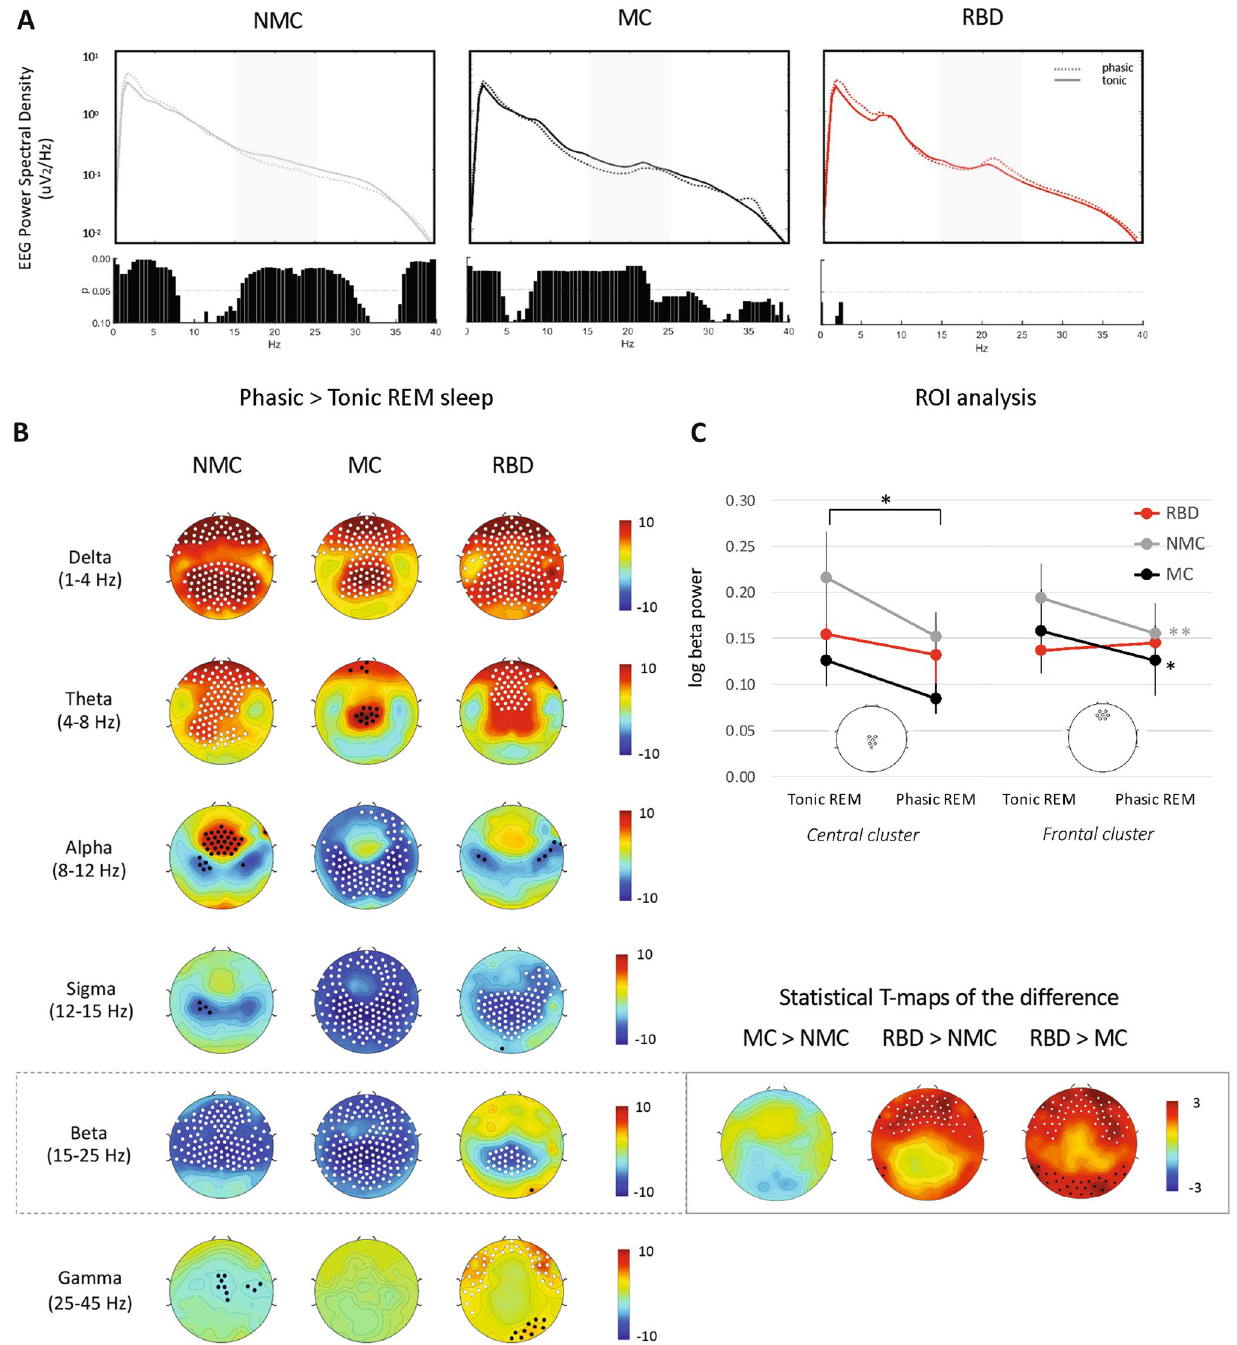
Figure 1. Spectral differences between phasic and tonic REM in RBD patients and controls. ( A ) Global EEG power spectra in phasic (dotted light) and tonic (continuous line) REM in the three groups. FDR-corrected p values from paired t-tests for the comparison between states within groups are shown below each plot, respectively. Greyed areas represent the beta band. ( B ) Normalized change in log power between phasic and tonic REM sleep across indicated frequency bands (delta: 1–4 Hz; theta: 4–8 Hz; alpha: 8–12 Hz; sigma: 12–15 Hz; beta: 15–25 Hz; and gamma: 25–40 Hz) for non-medicated controls (left column), medicated controls (middle column) and RBD patients (right column). White dots indicate p < 0.05 and black dots p < 0.1 after SNPM correction for one-sample t-test between both REM sleep sub-stages. Statistics on the changes showed significant differences between groups in the beta range only and are shown in the right insert. Individual channel t-maps are represented, with white dots indicating channels with SNPM corrected p < 0.05 and black dots uncorrected p < 0.05 after unpaired t-tests on the phasic to tonic REM power difference. ( C ) ROI analysis for central and frontal changes in absolute beta power between tonic and phasic REM sleep. Central and frontal ROIs were centered around Fz and Cz respectively and consisted of six and seven electrodes each (see inserts). Repeated-measure ANOVA with “group” and “REM sub-stage” on the log power revealed for the central cluster: a significant effect of REM sub-stage only ( p < 0.01); for the frontal cluster: a significant effect of REM sub-stage ( p < 0.01) and a trend for an interaction “group” × “REM sub-stage” ( p = 0.056). * and ** for p < 0.05 and p < 0.01 Tukey Kramer post-hoc test between “tonic” and